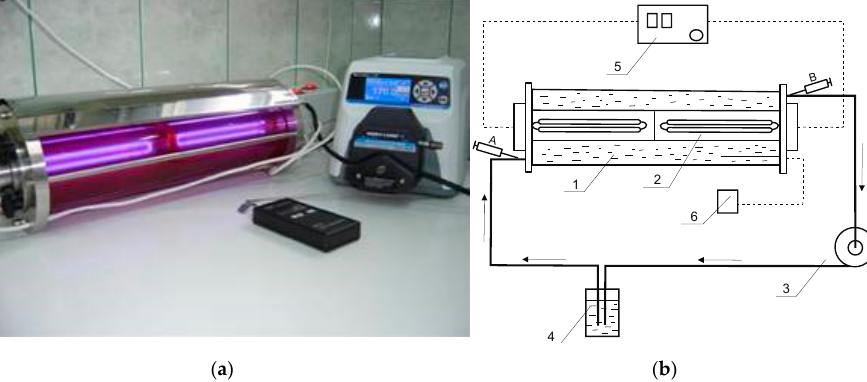
Figure 2. Reactor used for Roundup degradation by means of AOP technology. ( a ) Figure of a photoreactor with UV lamp used for the oxidation of PMG by means of UV/H 2 O 2 . ( b ) Schematic diagram: 1—glass reactor; 2—quartz tube with UV lamp (254 nm; 22 W); 3—peristaltic pump; 4—